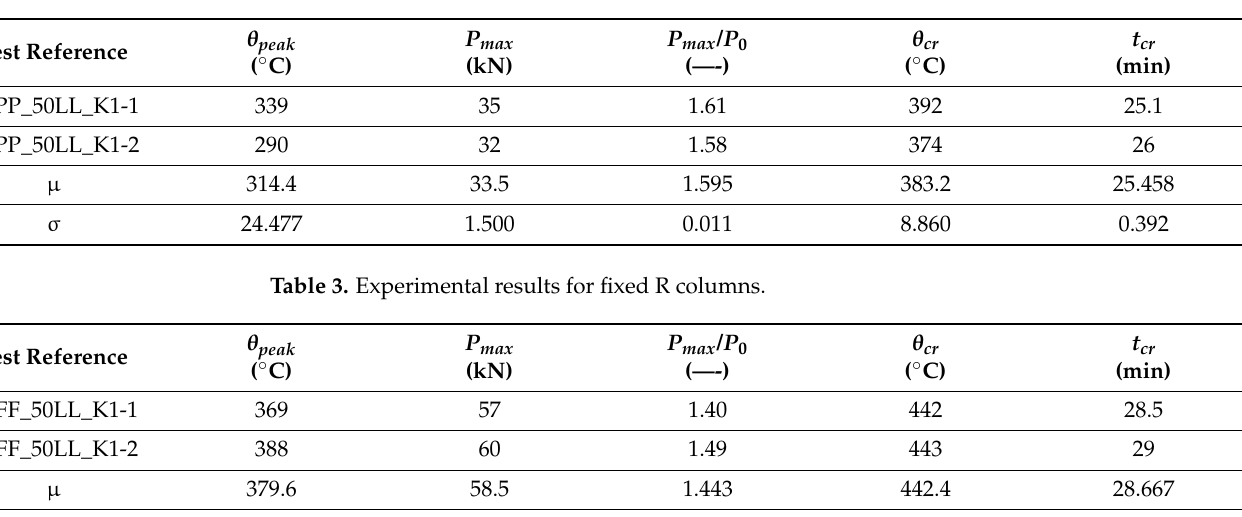
Table 2. Experimental results for pinned R columns.